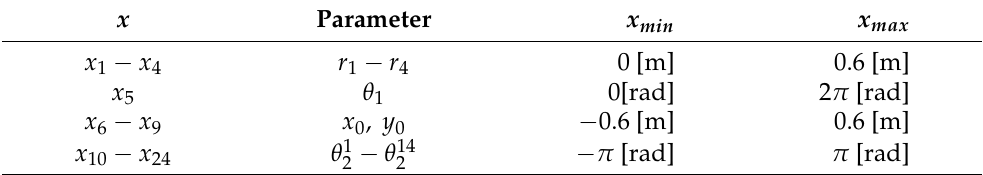
Table 2. The maximum and minimum parameters of the x vector for the four-bar mechanism.